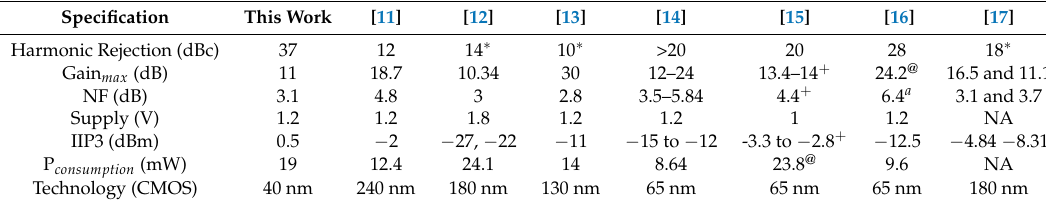
Table 3. Performance